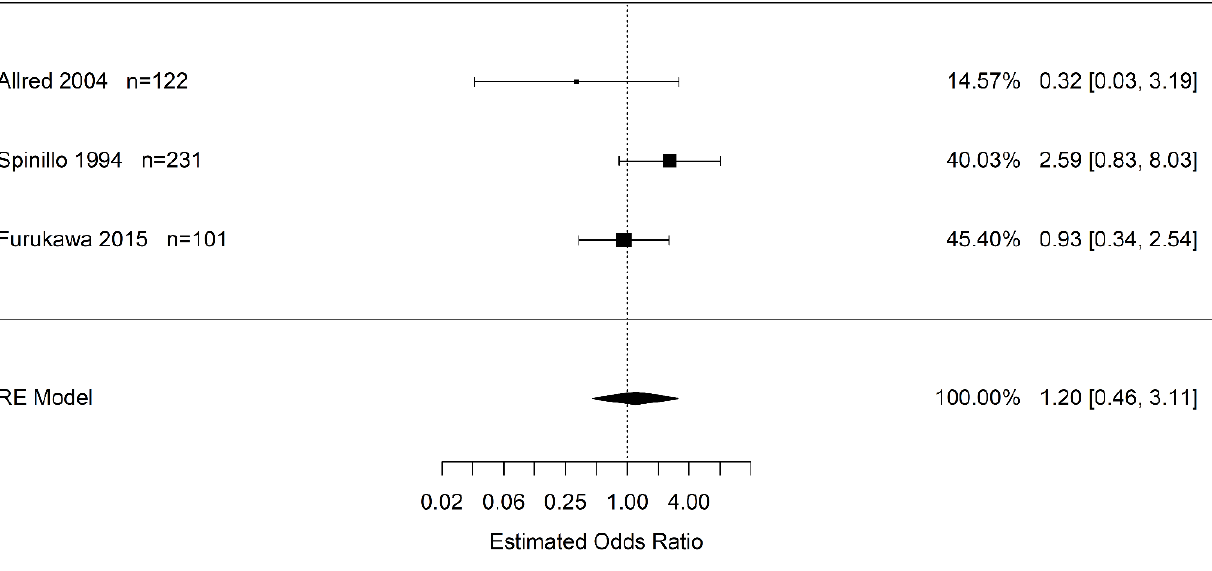
Figure 4. Estimate odds ratio of placental abruption (vs. “controls”) for intraventricular hemor ‐ rhage (any grade) calculated using random effects (RE) model. [45,50] Only two studies reported on the association of abruption and PVL. Resulting from very wide, imprecise confidence intervals including one, there is no statistically signifi ‐ cant difference in the odds of infants born to pregnant women with placental abruption who experience PVL vs. pregnant women without placental abruption (OR 6.51 95% CI (0.94, 45.16); I 2 = 0.0%) (Figure 5).